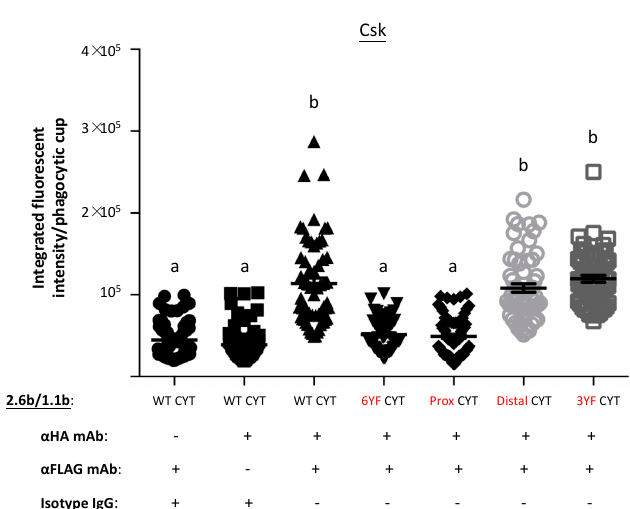
Figure 5. Confocal microscopic analysis of Csk recruitment to phagocytic cups following co-crosslinking of various IpLITR constructs. 2.6b ITAM CYT / 1.1b WT CYT co-expressing AD293 cells (2 × 10 5 ) ( A ) or AD293 cells co-expressing 2.6b ITAM CYT with various mutant 1.1b CYT constructs ( B ) were incubated at 37 ◦ C with 4.5 µ m non-fluorescent (NF) beads opsonized with the indicated mAbs and / or isotype IgG1 (’ + ’ and ‘ − ’ indicate the presence and absence of corresponding antibodies, respectively). After 8 min, cells were fixed with 4% PFA and non-phagocytosed beads were stained using Alexa 647-conjugated (red) goat- α -mouse secondary pAb. After the bead staining step, the cells were permeabilized and stained for Csk by incubating with a rabbit α -Csk mAb and then a secondary goat- α -rabbit pAb conjugated to Alexa 488 (green). Representative images from z-stack acquisitions are shown with Csk (top panels; green) staining, surface-exposed bead (middle panels; red) staining and merged-fluorescence images (bottom panels). Yellow arrowheads show positions of representative phagocytic cups and the accumulation of Csk staining at locations where extracellular bead staining is absent. ( C ) Quantitative analyses of Csk staining intensities at phagocytic cups were performed using ImageJ software. At least 50 phagocytic cups from three independent experiments were analyzed and the data is represented as mean integrated fluorescent intensity ± SEM. Di ff ering letters indicate statistical significance ( p ≤ 0.05) between means. Experimental groups were compared using a one-way ANOVA, followed by the Tukey test using Prism 6 software (GraphPad Software, La Jolla, CA, USA).